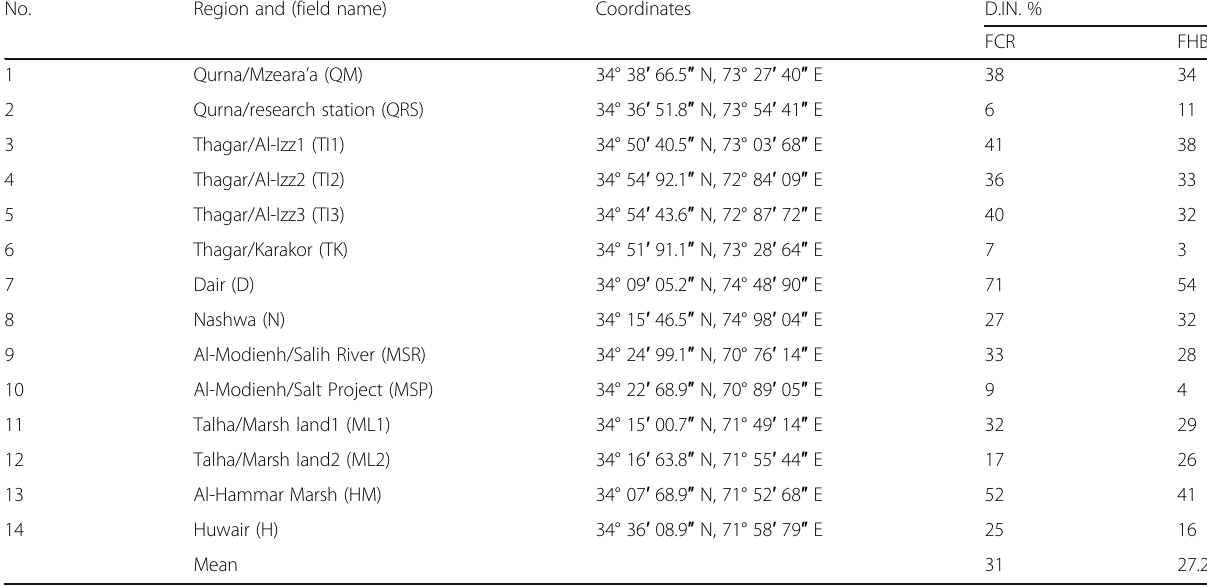
Table 2 The sampling sites and percentages of disease incidence of wheat in the 14 selected fields of the current study No. Region and (field name) Coordinates D.IN. %